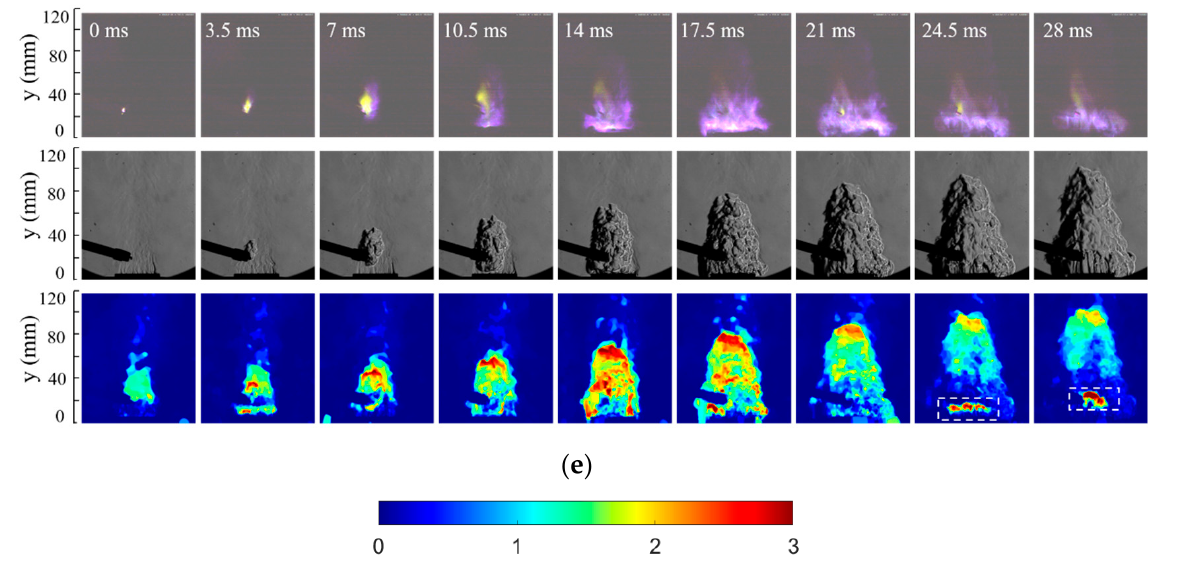
Figure 7. Flame image, schlieren image and velocity contours during ignition under different conditions: ( a ) no acoustic excitation; ( b ) 10 Hz excitation; ( c ) 30 Hz excitation; ( d ) 50 Hz excitation; ( e ) 100 Hz excitation.